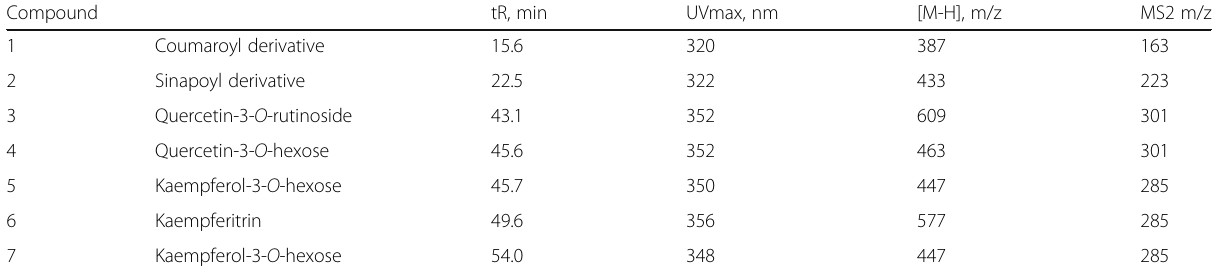
Table 5 Compounds identified in U. dioica fraction 7 by HPLC-PDA-ESI-MS/MS